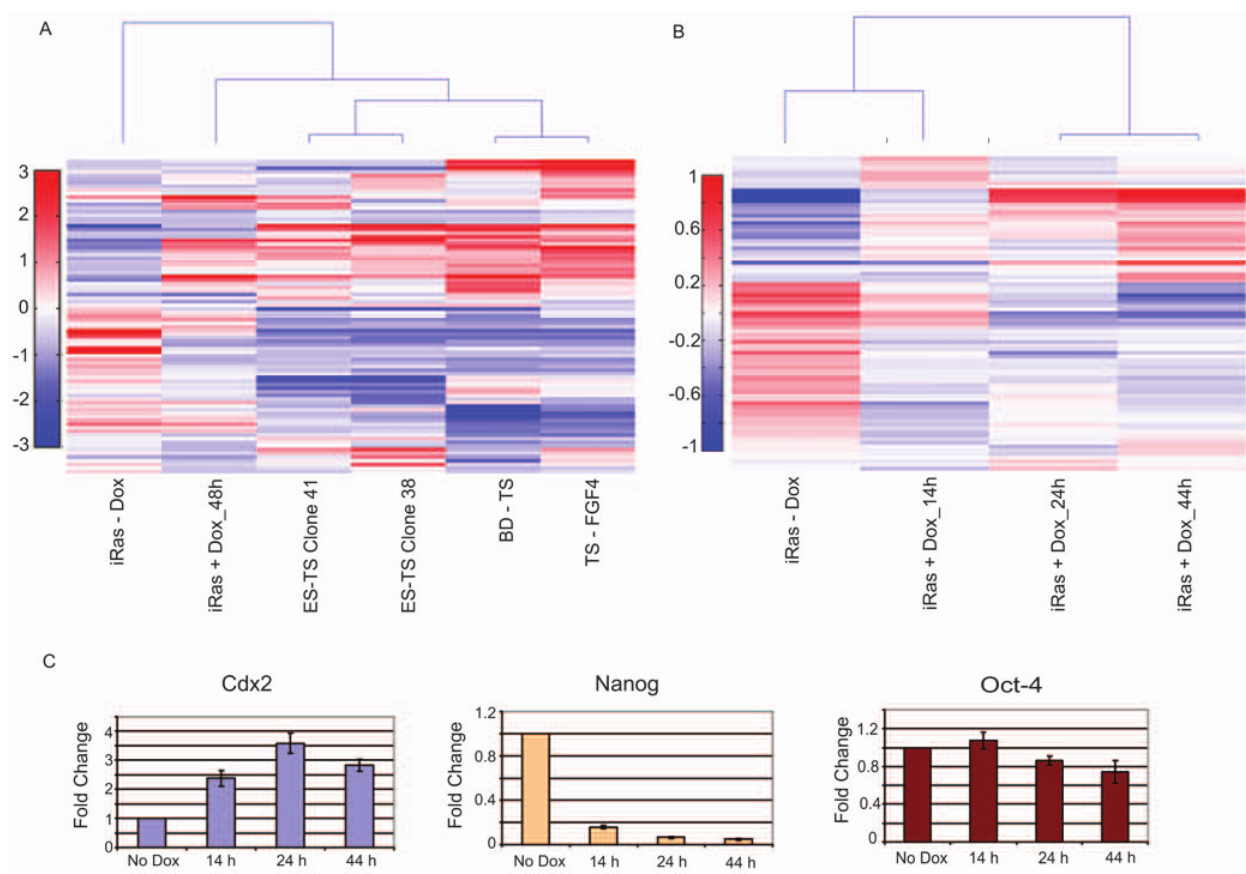
Figure 2. miRNA expression profiling during invitro TE differentiation. a) unsupervised hierarchical clustering of miRNA expression to compare iRas-ESCs, iRas-ESC-derived TS cells (ES-TS cells), and BD-TS cells. b) unsupervised hierarchical clustering miRNA expression in iRas-ESCs after various time points of HRas/Q61L induction. c) quantitative PCR analysis of ES-specific (Oct-4 and Nanog) and TE-specific (Cdx2) marker genes after various time points of HRas/Q61L induction.